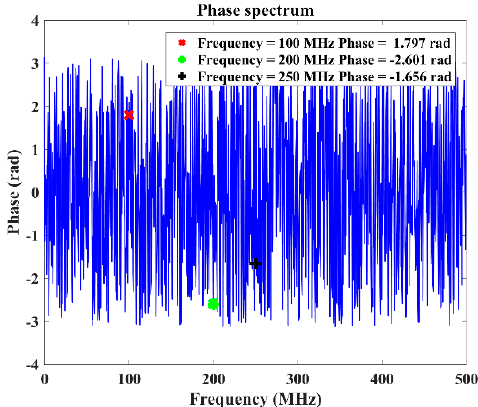
Figure 4. Phase spectrum of cross-spectrum.